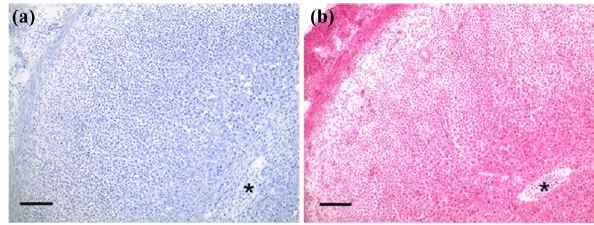
Figure 5: Mouse uteri of early pregnancy on day 6 stained with TB ( a ) and XP ( b ) . * = embryo. 100 × fi nal magni fi cation. Bar = 60 µm.